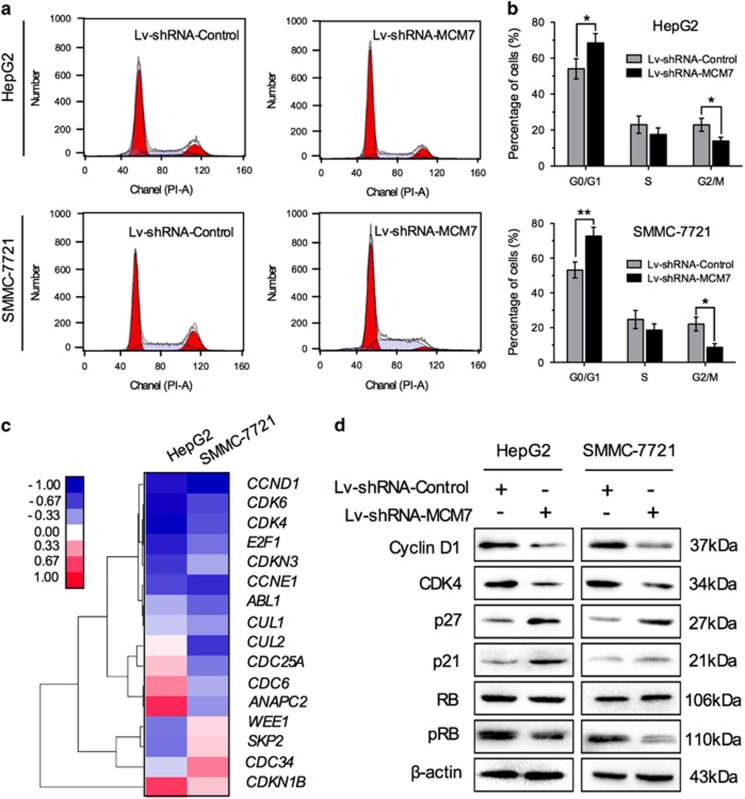
Downregulation of MCM7 restrains cell cycle progression by suppressing cyclin D1 expression. (a and b) Cell cycle analysis of HCC cells transfected by Lv-shRNA-MCM7 or Lv-shRNA-Control. (c) A total of 16 cell cycle-related genes were screened after lentiviral vector transduction. (d) Western blot analysis of cyclin D1, CDK4, p27, p21, total RB and p-RB in HCC cells after lentiviral vector transduction. Data are represented as mean±S.E.M. from three independent experiments. *P<0.05; **P<0.01